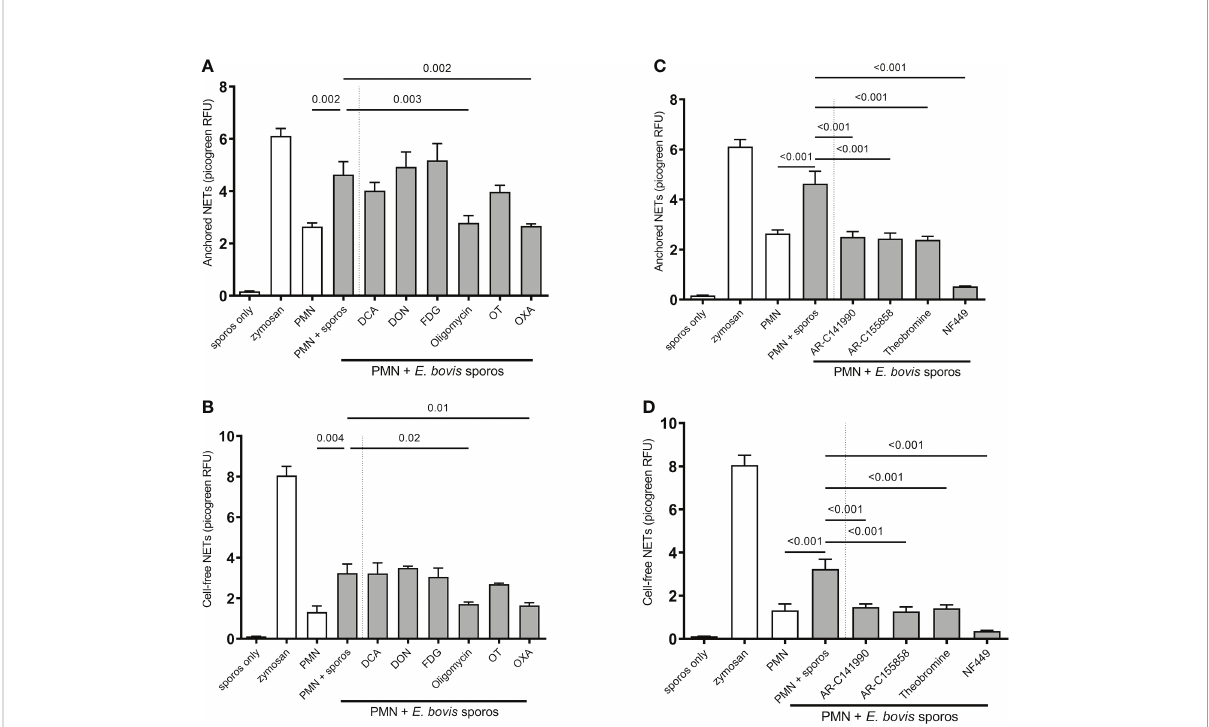
FIGURE 7 Effects of glycolysis, glutaminolysis, purinergic signaling (P2X1, P1A1), and monocarboxylate transporter (MCT) inhibition on E. bovis sporozoite- induced NETosis. Bovine PMN were pretreated for 30 min with FDG (2 mM), DCA (8 mM), OT (50 µM), OXA (50 mM), oligomycin (5 µM), DON (4 µM), NF449 (100 µM), theobromine (100 µM), AR-C141990 (1 µM), and AR-C155858 (1 µM), followed by the exposure to E. bovis sporozoites (ratio 1:4). For negative controls, PMN in plain, serum-free medium RPMI 1640 without phenol red was used. Stimulation of PMN with zymosan (1 mg/ml) served as a positive control. After 2 h of incubation, samples were directly centrifuged at 300 × g for 5 min. The pellets were used for ‘ anchored ’ -NET estimation (A, B) , and the supernatants were collected for ‘ cell-free ’ -NET measurements (C, D) . Extracellular DNA was detected and quanti fi ed by picogreen-derived fl uorescence intensities using an automated multi-plate reader. All data were performed and analyzed